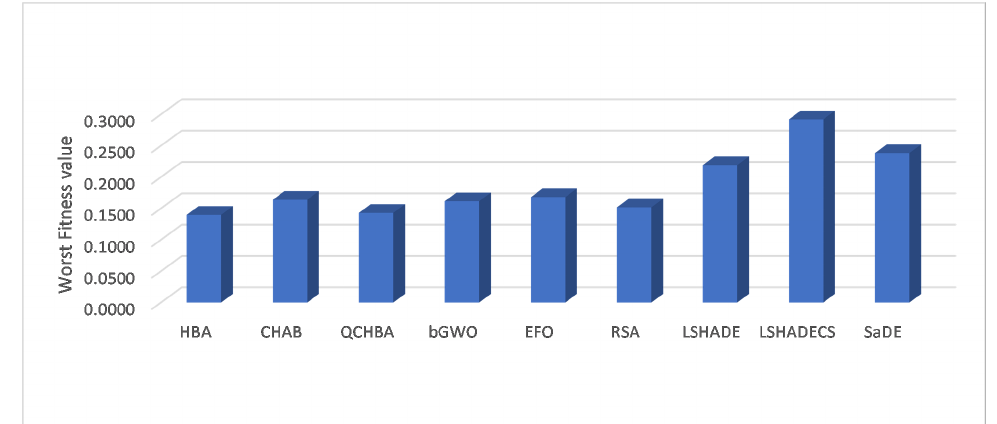
Figure 8. Efficiency of QCHBA and other methods based on the average number of selected